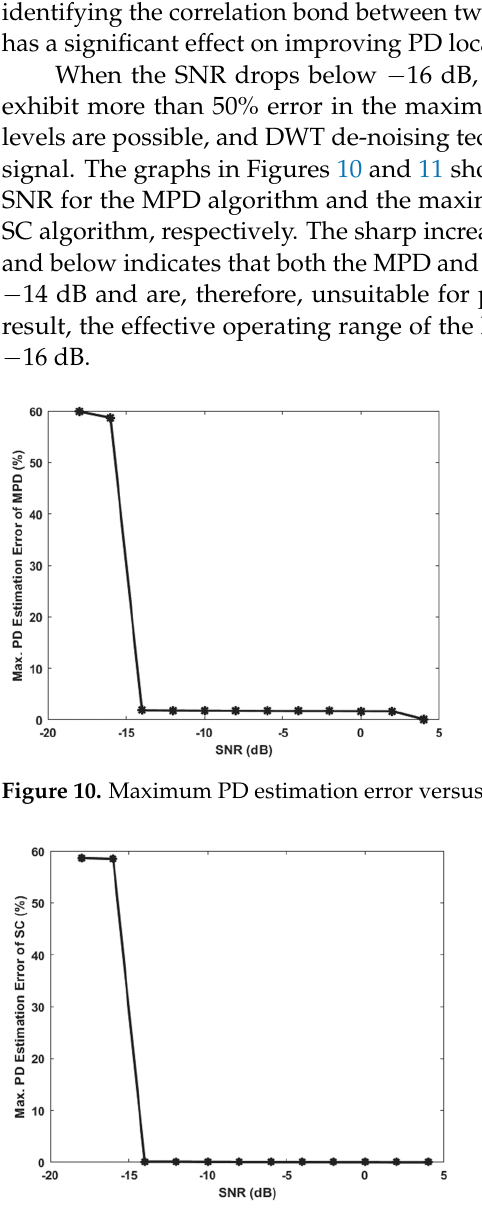
Table 4. Maximum PD estimation error.